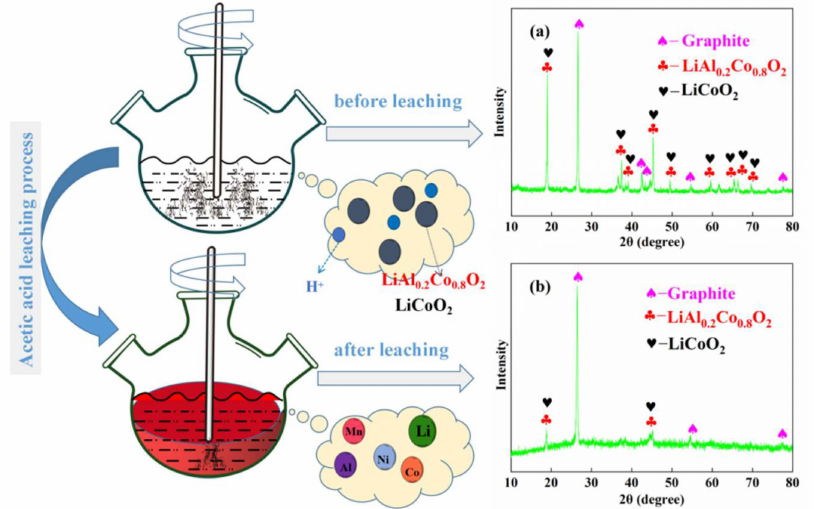
Figure 1. XRD patterns for:( a ) electrode materials after calcination and grinding but before leaching and ( b ) black residues after